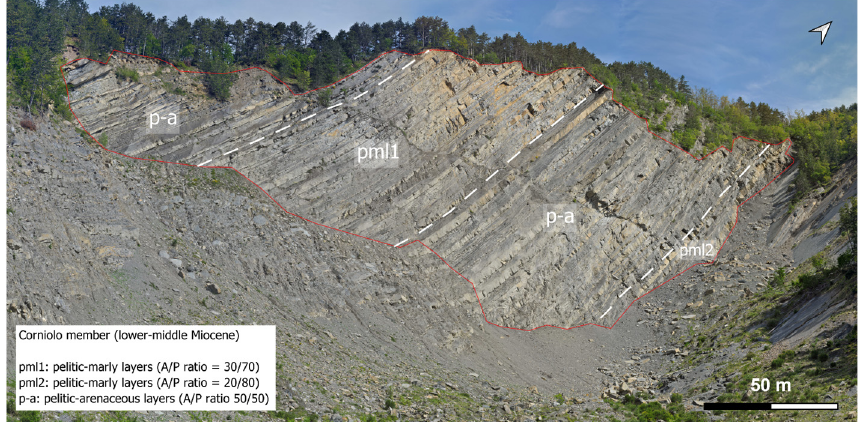
Figure 2. Front view of the main Poggio Baldi landslide scarp. The three different members of the Marnoso-Arenacea Formation are distinguished by the different content ratios of marly and arenaceous